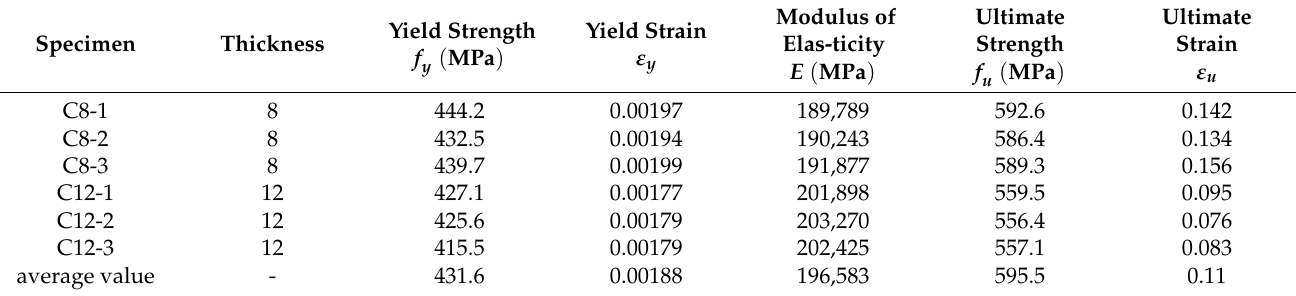
Table 2. Tensile test results of Q355